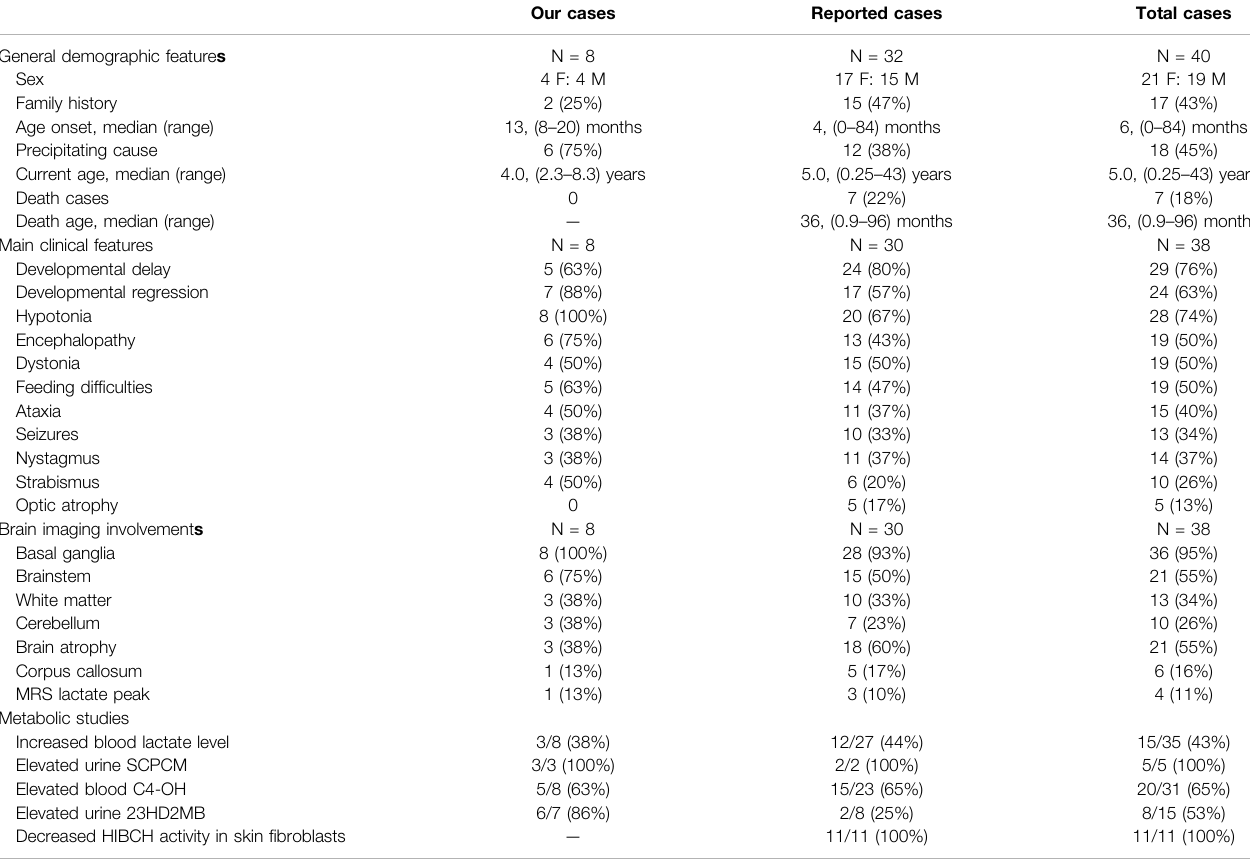
TABLE 4 | The clinical, neuroimaging and metabolic characteristics of our cases and the reported HIBCH mutation